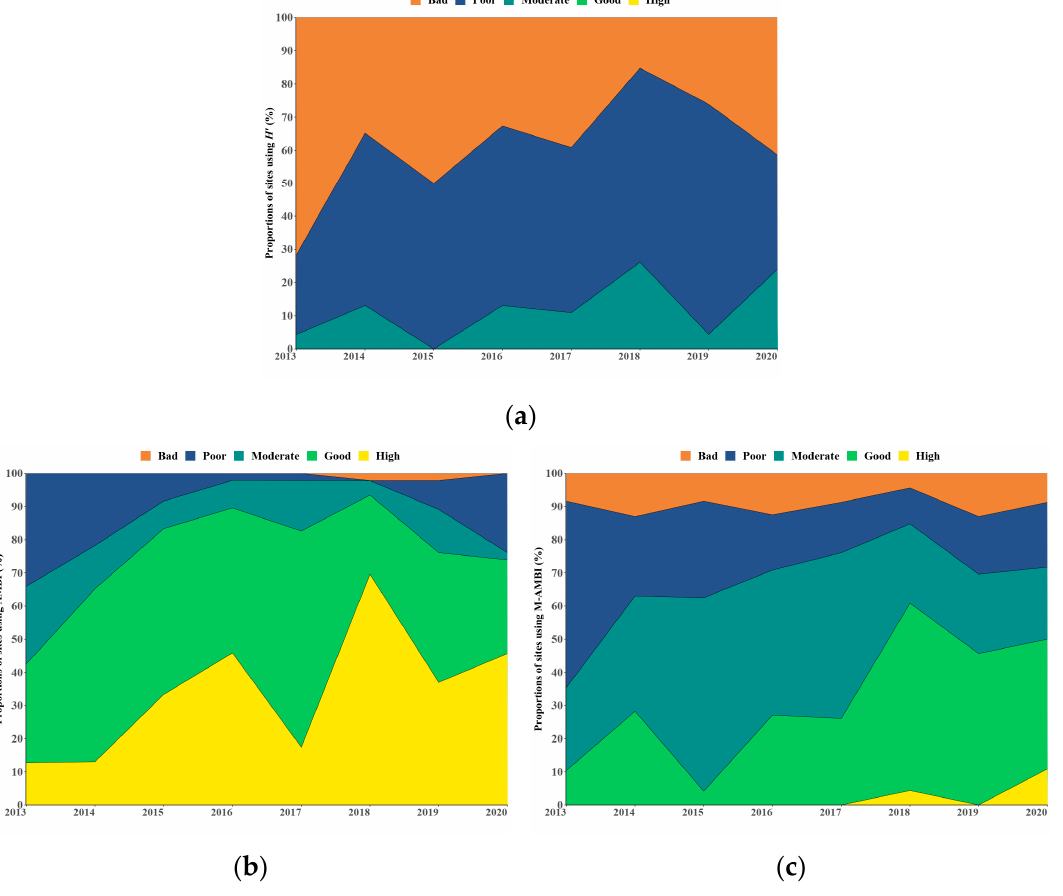
Figure 2. Proportions of sites using H ′ ( a ), AMBI ( b ), and M-AMBI ( c ) from 2013 to 2020. Note: “high” or “good” indicates the acceptable condition, and the benthic habitat was not significantly impacted; “moderate” “poor” and “bad” indicates unacceptable conditions, and the benthic habitat was moderately or severely impacted.